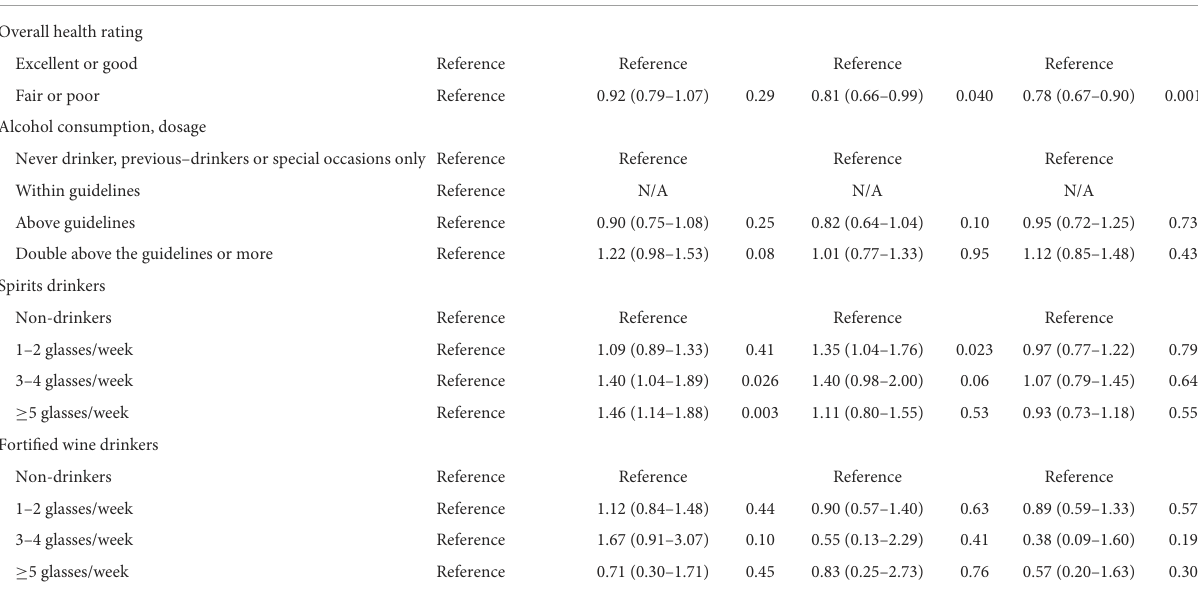
TABLE 9 Odds ratios and 95% CIs for the interaction effect between beer and cider and the risk of